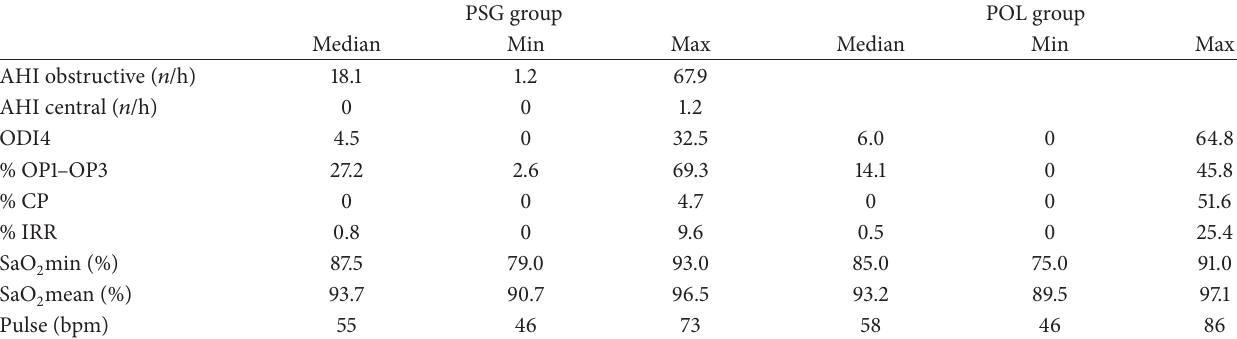
Table 3: The respiratory parameters of the PSG group and the POL group.